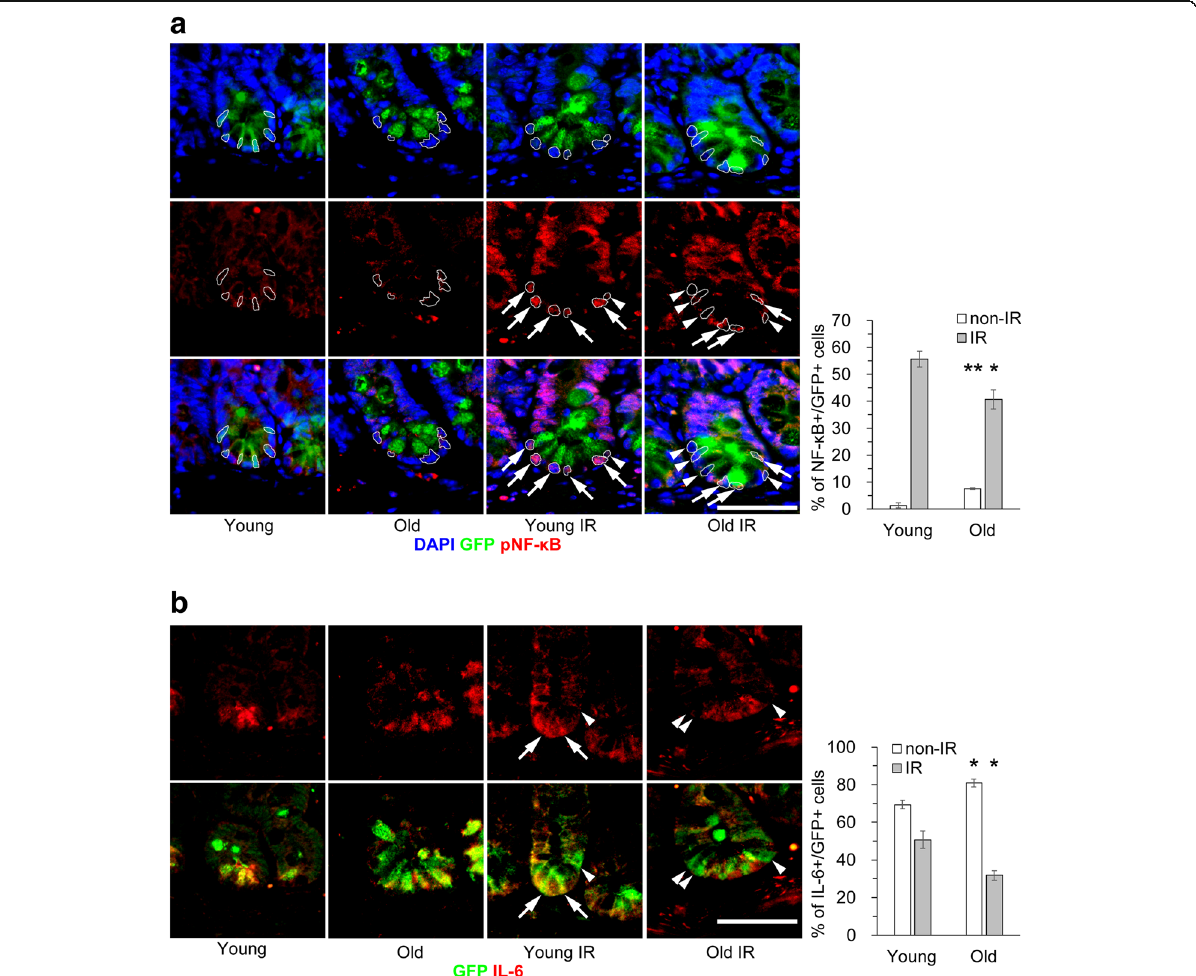
Fig. 2 Expression of inflammatory factors is decreased in old ISCs. Immunohistochemical analyses of inflammatory factors were performed in young and old jejunum with (IR) or without 10 Gy X-ray irradiation (non-IR). Representative images stained with anti-pNF- κ B and anti-IL-6 antibodies, together with graphs of the percentages of positive cells, are shown in a and b , respectively. Arrows and arrowheads indicate GFP and pNF- κ B or IL-6 double-positive and GFP single-positive cells, respectively. Data are mean ± s.e.m. ( n = 3 and > 100 GFP+ cells). * p < 0.05, ** p < 0.01. Scale bars, 50 μ